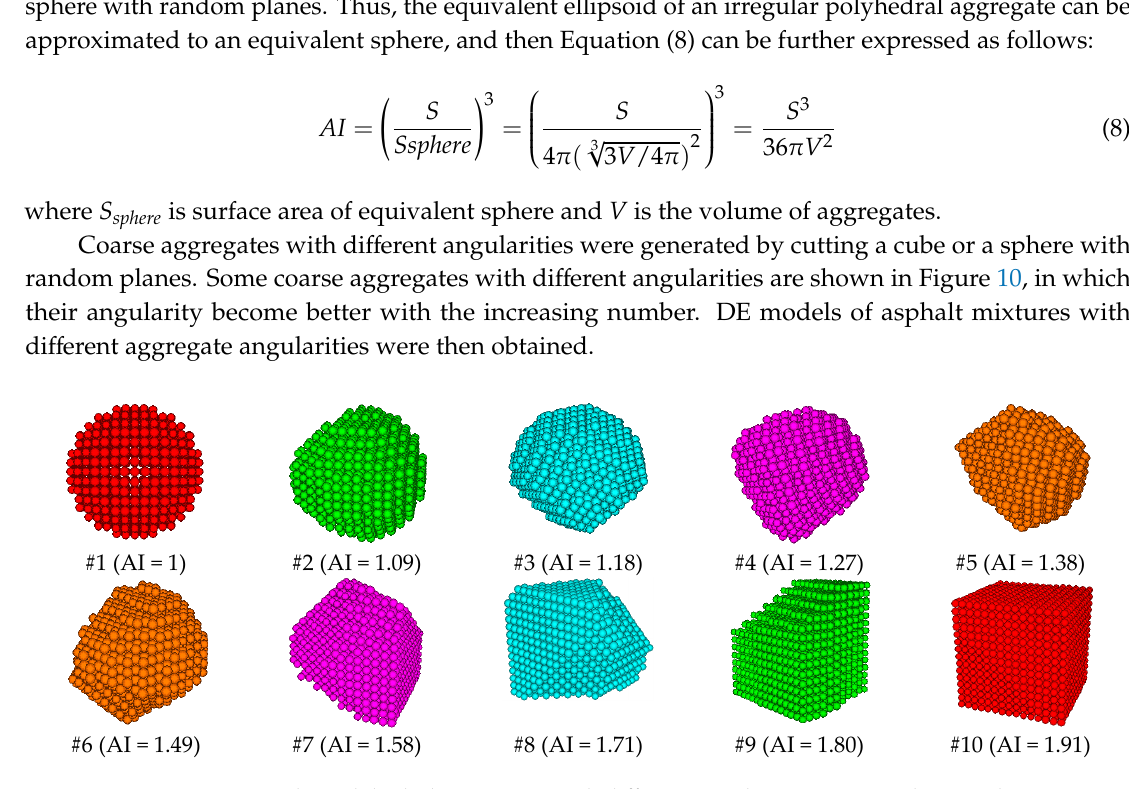
Figure 10. Irregular polyhedral aggregates with different angularities. AI: angularity index.